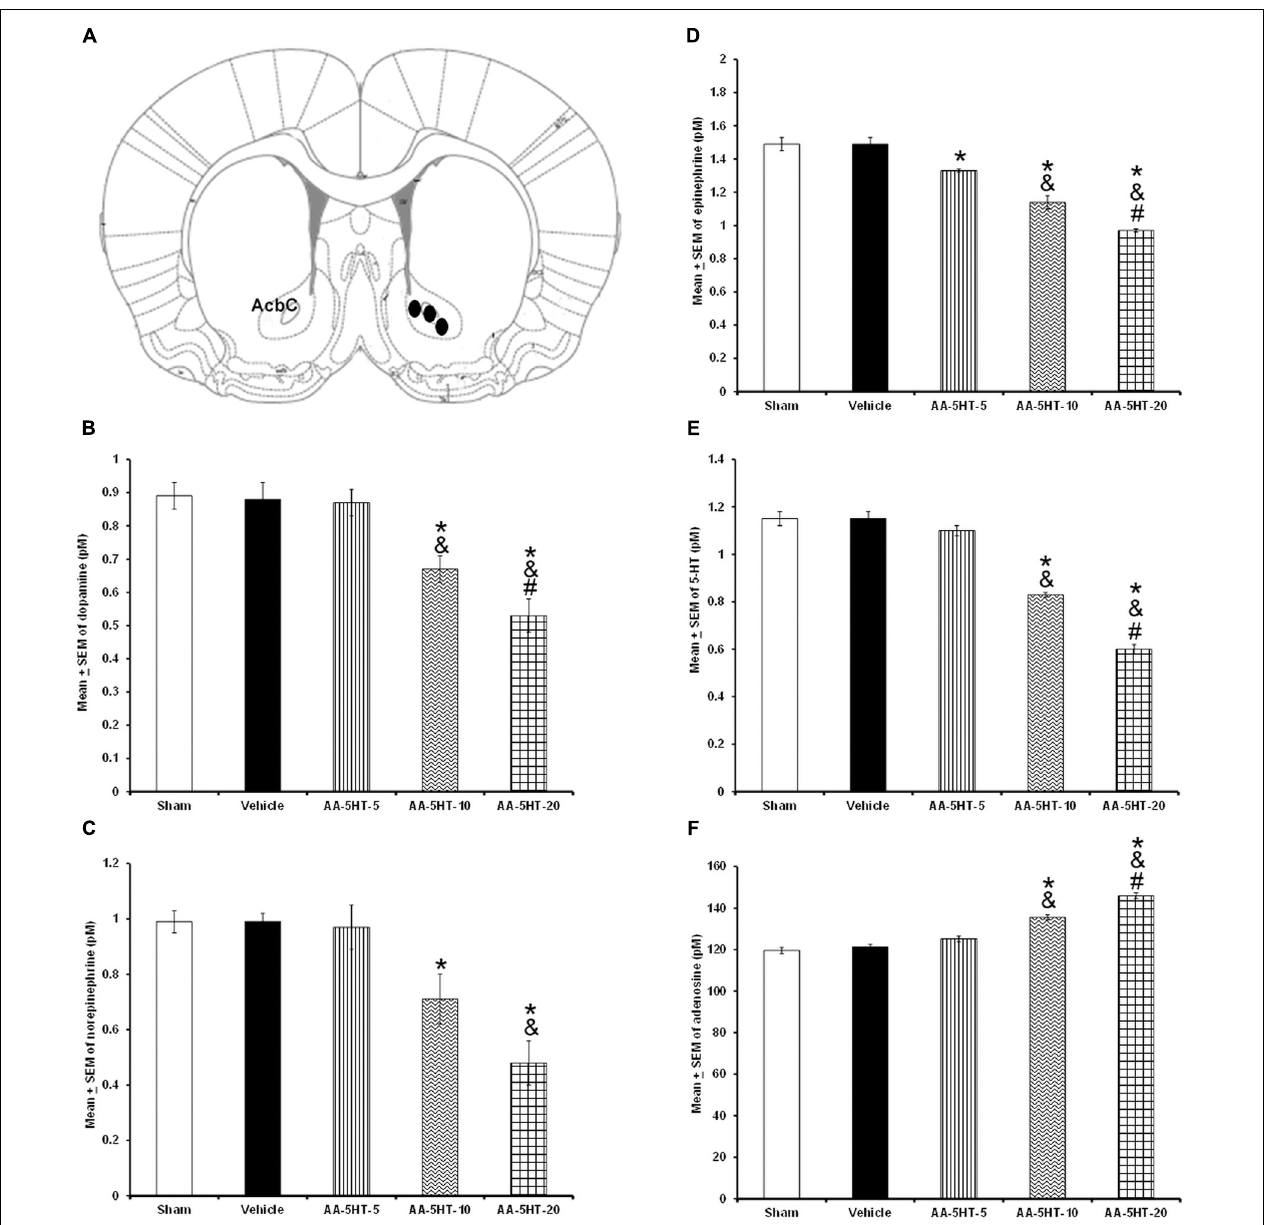
FIGURE 3 | Effects of administration of AA-5-HT (5, 10, or 20 mg/Kg; i.p.) during the lights-off period on the extracellular levels of dopamine (DA), norepinephrine (NE), epinephrine (EP), serotonin (5-HT), and adenosine (AD). Schematic representation of position of the microdialysis probe into AcbC ( A - Black dots represent the tip of microdialysis probe). AA-5-HT decreased the contents of DA, NE, EP, and 5-HT whereas AD levels were enhanced ( B–F , respectively. Mean ± SEM ∗ vs. Sham/Vehicle, P < 0.05; & vs. AA-5-HT-5, P < 0.05; # vs. AA-5-HT-10, P < 0.05). Abbreviations: AA-5-HT-5 mg/Kg (AA-5-HT-5), AA-5-HT-10 mg/Kg (AA-5-HT-10), AA-5-HT-20 mg/Kg (AA-5-HT-20). Drawing taken from Paxinos and Watson Rat Brain Atlas (2005).